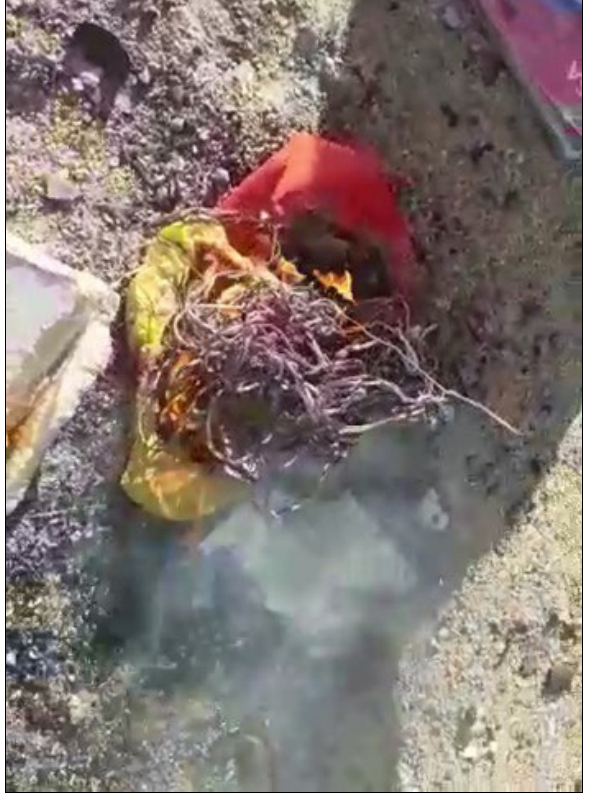
Figure 4: Demonstration of copper burning by waste pickers.